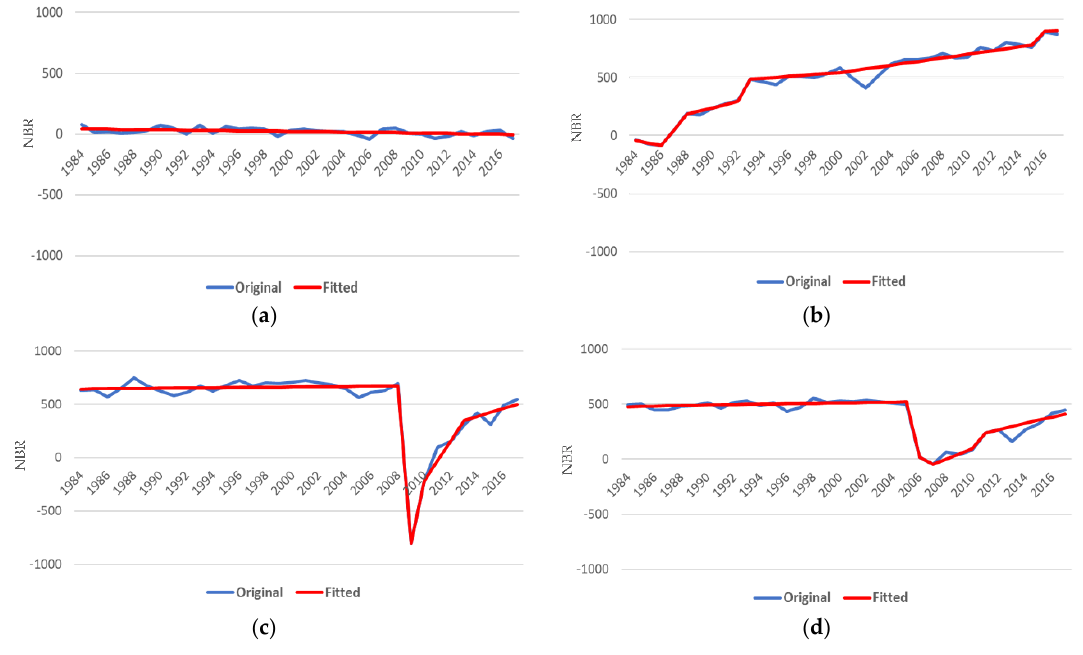
Figure 4. Graph depictions of the spectral trends observed at pixel level using the Normalized Burn Index (NBR) scaled by 1000 from 1984 to 2017. ( a ) Stable areas over time; ( b ) recovery areas; ( c ) disturbed areas with a high magnitude of change; and ( d ) disturbed areas with a low magnitude of change.